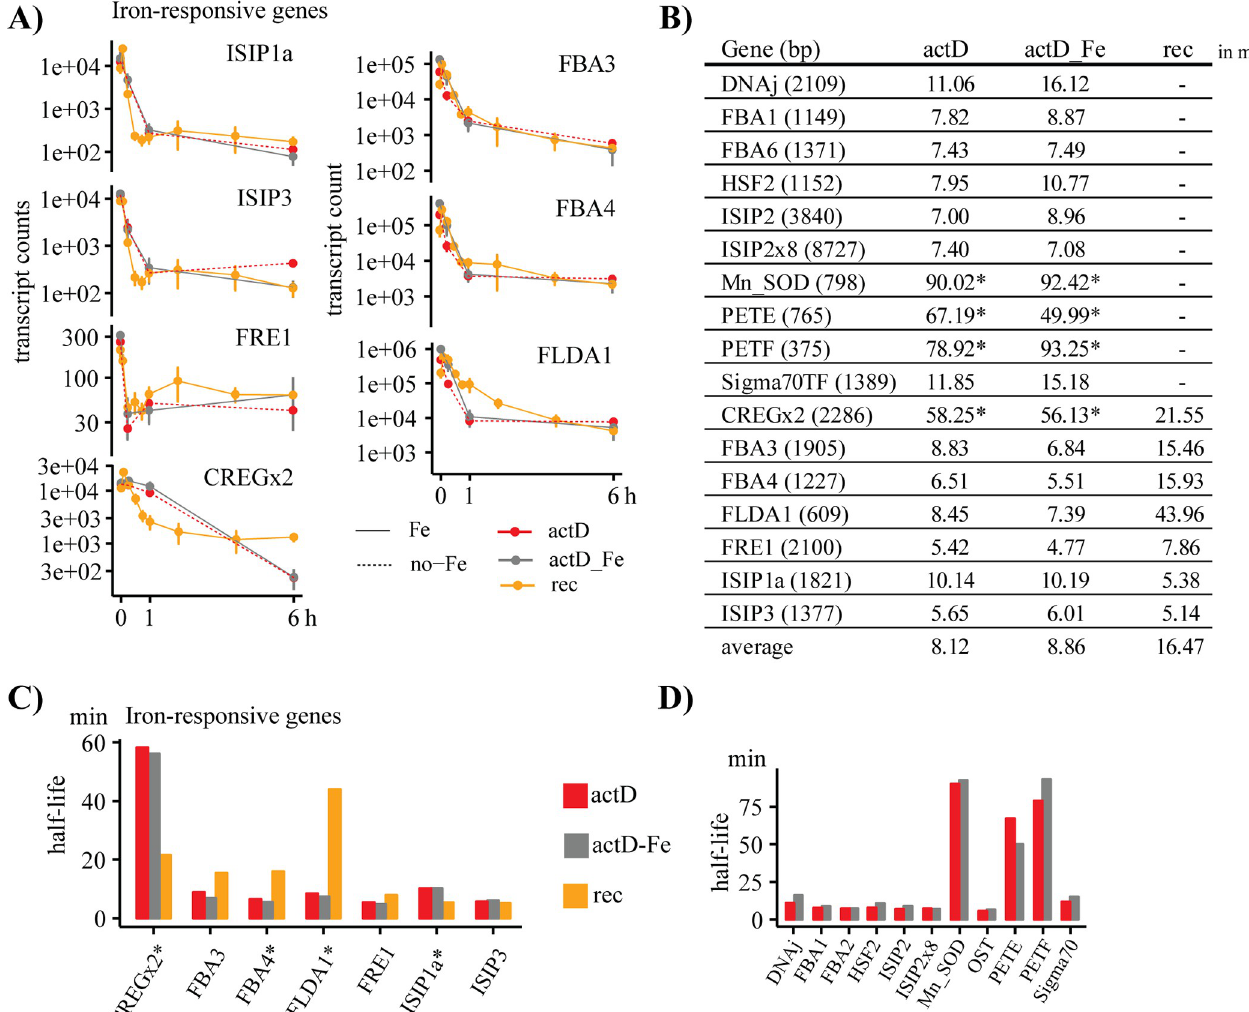
Fig 6. Overview of actinomycin D treatment on transcript counts compared to iron-induced reduction of mRNA transcripts. (A) Changes in transcript counts over time (6 h) in iron-recovery (rec; orange), actD-treated cells (actD–red, actD-Fe–grey). All samples shown here were low-iron samples. ActD cultures received actinomycin D and actD-Fe cultures received actinomycin D and iron. Rec are low-iron samples that received only iron. (B) Table of half- lives for transcripts analyzed in the ST-experiment (in min). Values with an asterisk are excluded from the average. (C) Bar graphs of half-lives of the 7 rapidly declining iron-responsive genes. Transcripts with an asterisk revealed significant differences between actD and iron-recovery samples. (D) Bar graphs of half- lives for non-iron-responsive genes.